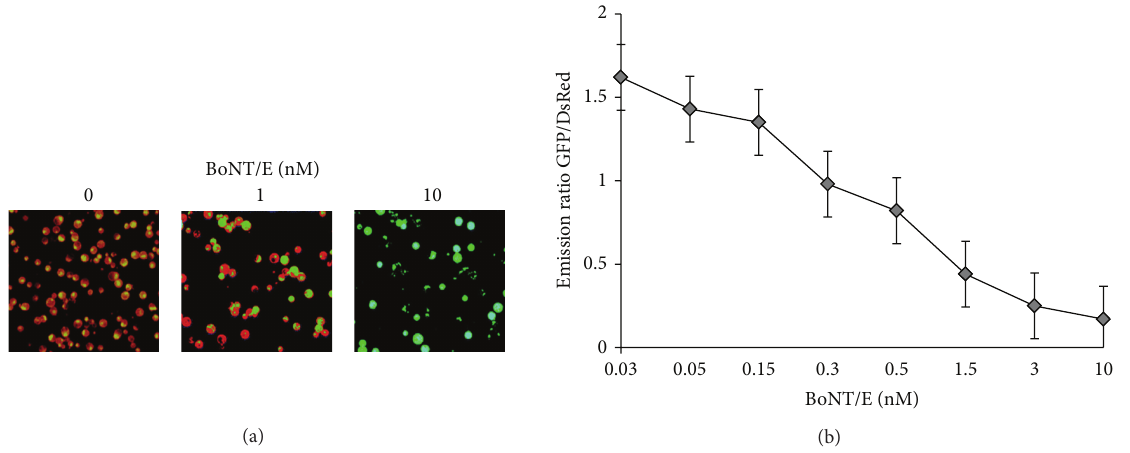
Figure 4: (a) BoNT/E responses of the clone 3A14. PC12 cells were grown in 96 well plates treated with the indicated BoNT/E concentration for 72h and imaged using fluorescence microscopy. Pseudocolored images indicate the distribution of the GFP/DsRED fluorescence ratio within thecells. (b) Monitoring BoNT/E activity using a microplate reader. The GFP and DsRED emissions were also collected by fluorescence microplate reader (BioTek). Emissions were plotted as a function of BoNT/A at 0.03, 0.05, 0.15, 0.3, 1.5, 3.0, and 10nM concentrations. Data are presented as means ± SD ( 𝑛 = 3